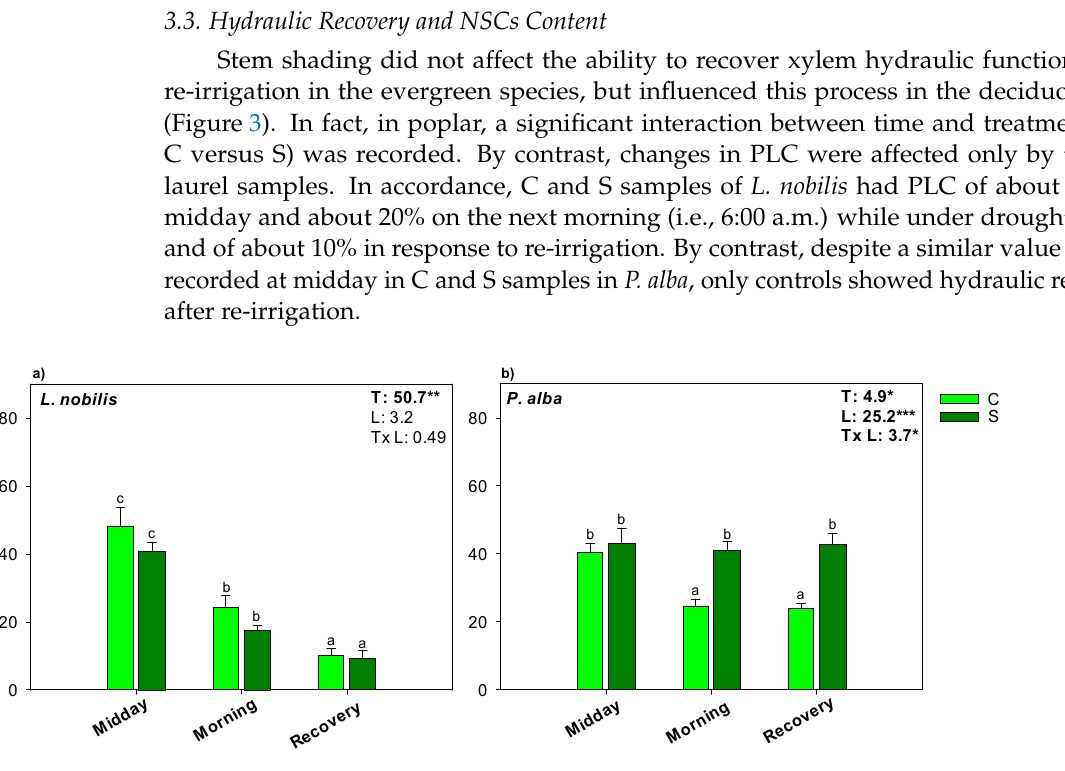
Figure 3. Mean values ± SEM of percentage loss of hydraulic conductivity (PLC) as recorded in control (C) and shaded stem (S) samples of L. nobilis ( a ) and P. alba ( b ) as measured at midday, on the following morning (Morning) as well as in samples re-irrigated at field capacity and measured 7 days after re-irrigation (Recovery). Light green and dark green columns refer to C and S samples, respectively. F values, as obtained by the two-way ANOVA analysis, are reported. Time of measurement, T, and light treatment, L (i.e., control and shaded samples) are the explanatory variables. * = p < 0.05; ** = p < 0.01; *** = p < 0.001.